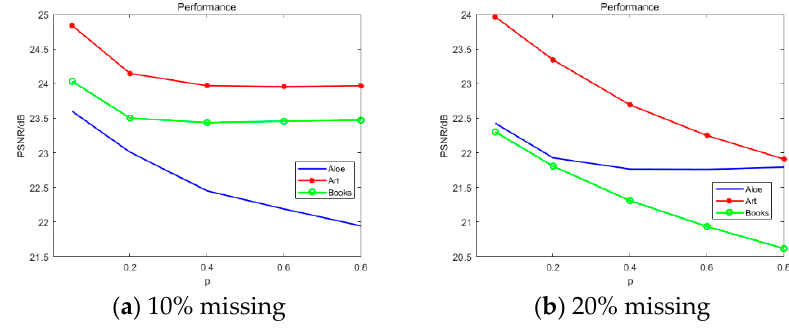
Figure 8. Performance comparison with p